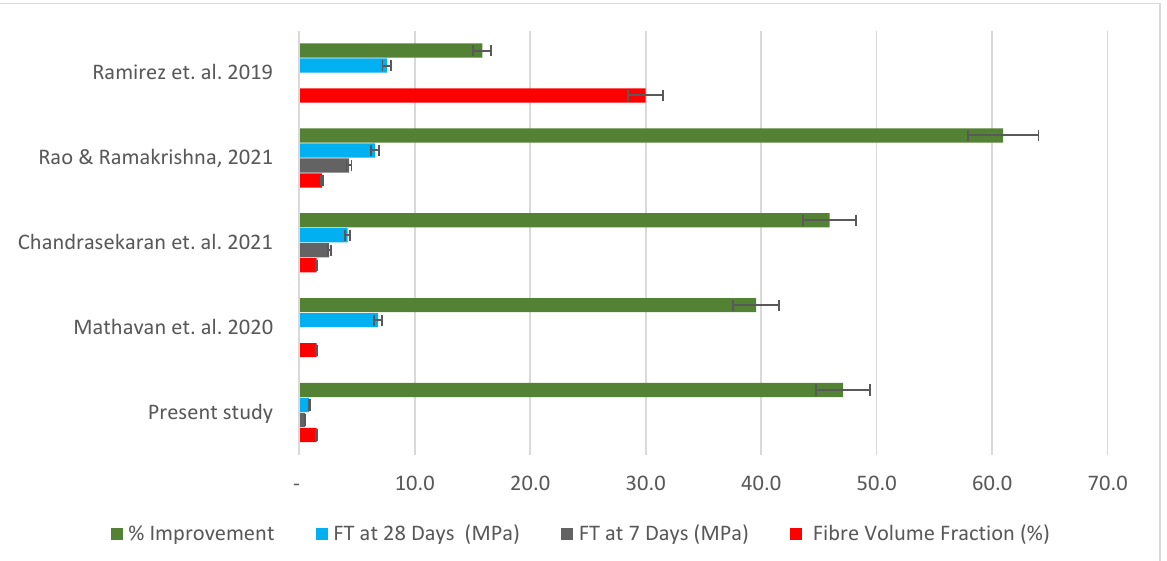
Figure 12. Chart expressing comparison of present study with previous studies in terms of optimal flexural strength values and improvement attained [22,32 – 34].